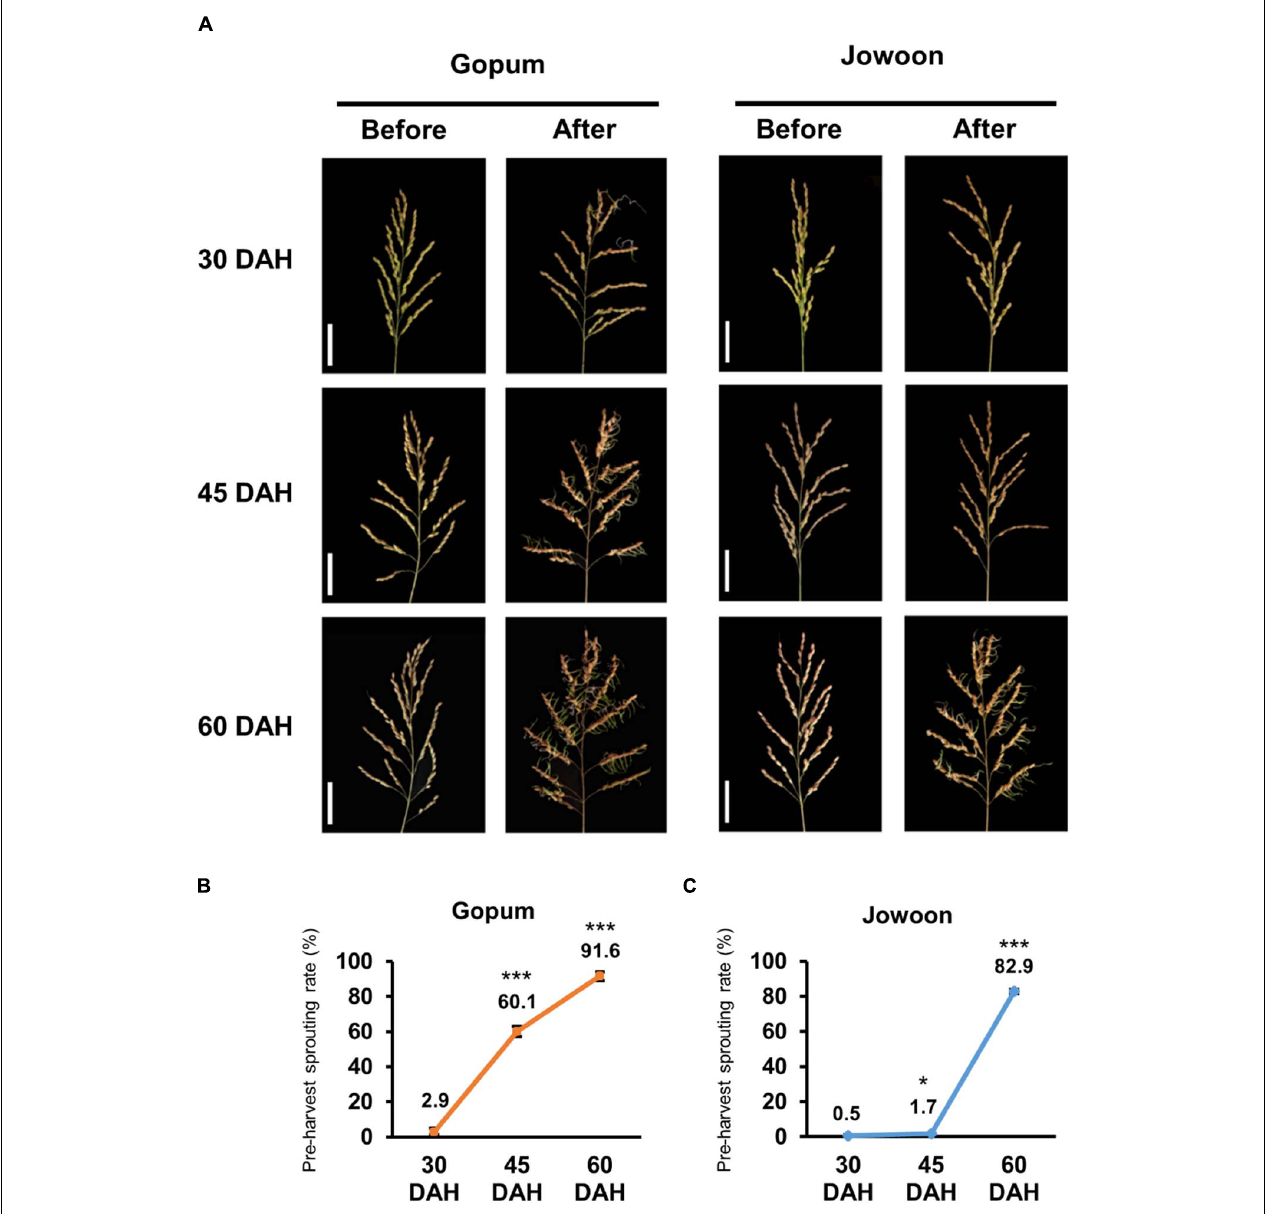
FIGURE 1 | Pre-harvest sprouting (PHS) assay in Gopum and Jowoon. (A) PHS phenotypes of Gopum and Jowoon at 30, 45, and 60 days after heading (DAH). The phenotypes before PHS assay (before) and after PHS assay (after) are shown. Scale bar = 5 cm. (B,C) PHS rate of Gopum (B) and Jowoon (C) at 30, 45, and 60 DAH ( N = 3). Significance is determined by Student’s t- test, * P < 0.05 and *** P <